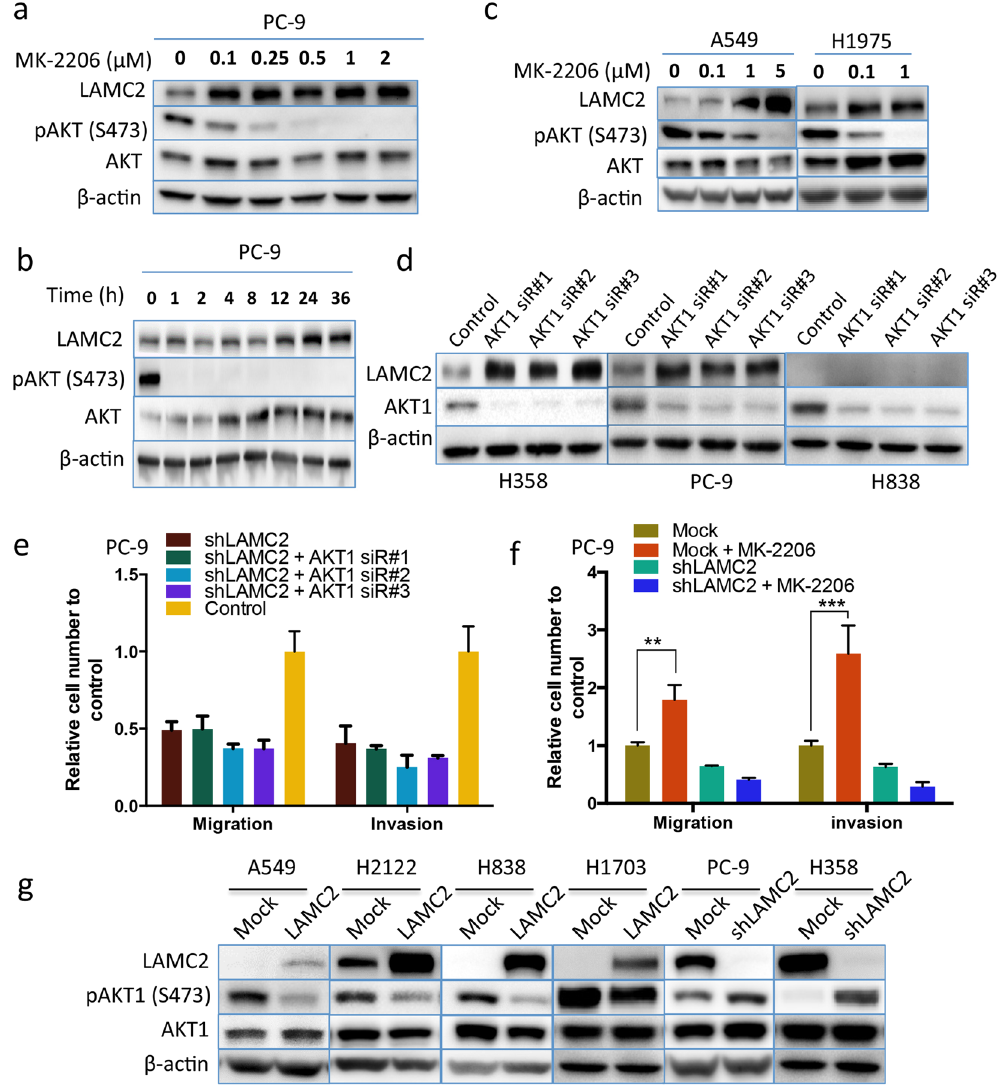
Figure 4. Upregulation of LAMC2 is required for migration and invasion resulting from AKT1 inhibition. Expression of LAMC2 and the phospho- and total AKT in ( a ) PC-9 cells treated with the indicated concentration of MK2206 for 24 hours, ( b ) PC-9 cells treated with 1 µ M MK-2206 for the indicated times, and ( c ) A549, and H1975 cells treated with the indicated concentrations of MK-2206 for 24 hours. ß-actin was also detected for loading controls. ( d ) Western blot detection of LAMC2 and AKT1 in H358, PC-9 and H838 cells transfected with three distinct AKT1 siRNAs (10 nM) for 48 hours. Migration and invasion of ( e ) PC-9 cells transfected with LAMC2 shRNA with/without AKT1 siRNA treatment for 48 hours and ( f ) PC-9 cells with/ without LAMC2 shRNA and/or 1 μ M MK-2206 for 24 hours. *** P < 0.001. ( g ) Western blot analysis of LAMC2 and the phospho- and total proteins of AKT1 in A549, H2122, H838 and H1703 cells stably transfected with LAMC2 expression vector, or in PC-9 and H358 cells infected with shLAMC2 lentiviral expression